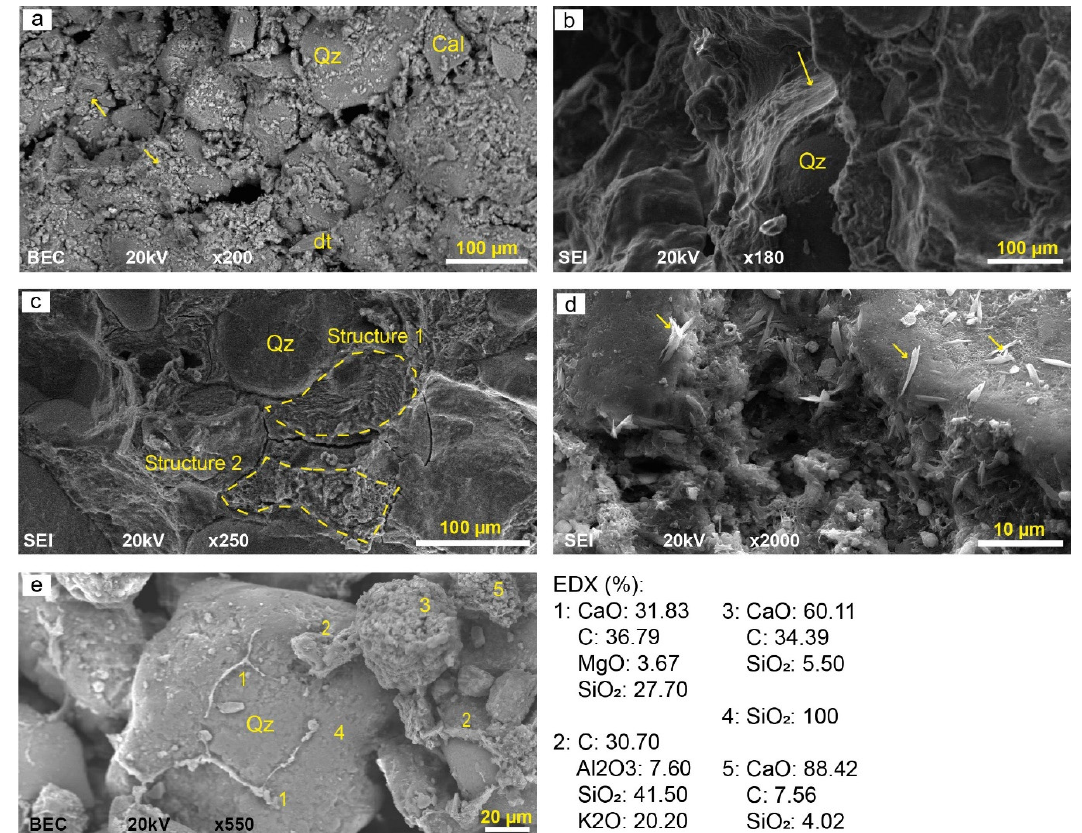
Figure 7. Scanning electron photomicrographs. ( a ) General overview of the sediments. The yellow arrows indicate the aggregations of clay minerals; ( b ) thin sheet of clay minerals coating quartz crystals; ( c ) two different structures of clays between the grains (structure 1—pore-bridging and structure 2—webby shape); ( d ) acicular clay minerals scattered on the surface of other crystals; ( e ) elongated Mg-rich clays above quartz (1), associated with clays rich in Al and K (2) and calcite (3). Qz—quartz, Cal—calcite, Dt—diatom.